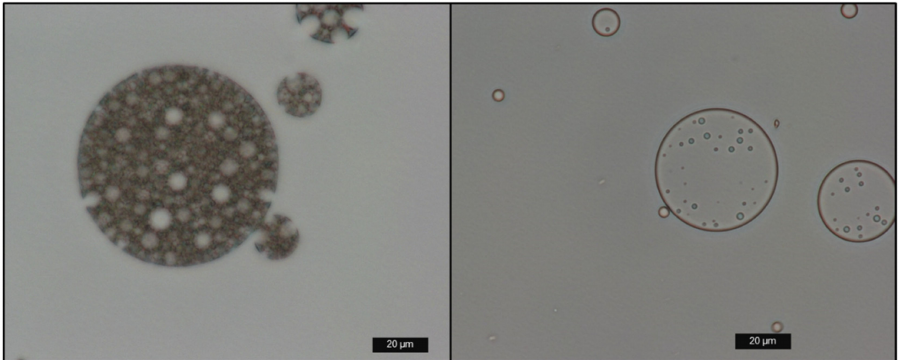
Figure 3. Examples of optical microscope images of double emulsions. Left: stable double emulsion droplets, which contain many inner droplets, resulting in dark droplets. Right: most of the inner droplets are lost due to coalescence or di ff usion. Black bar: 20 µ